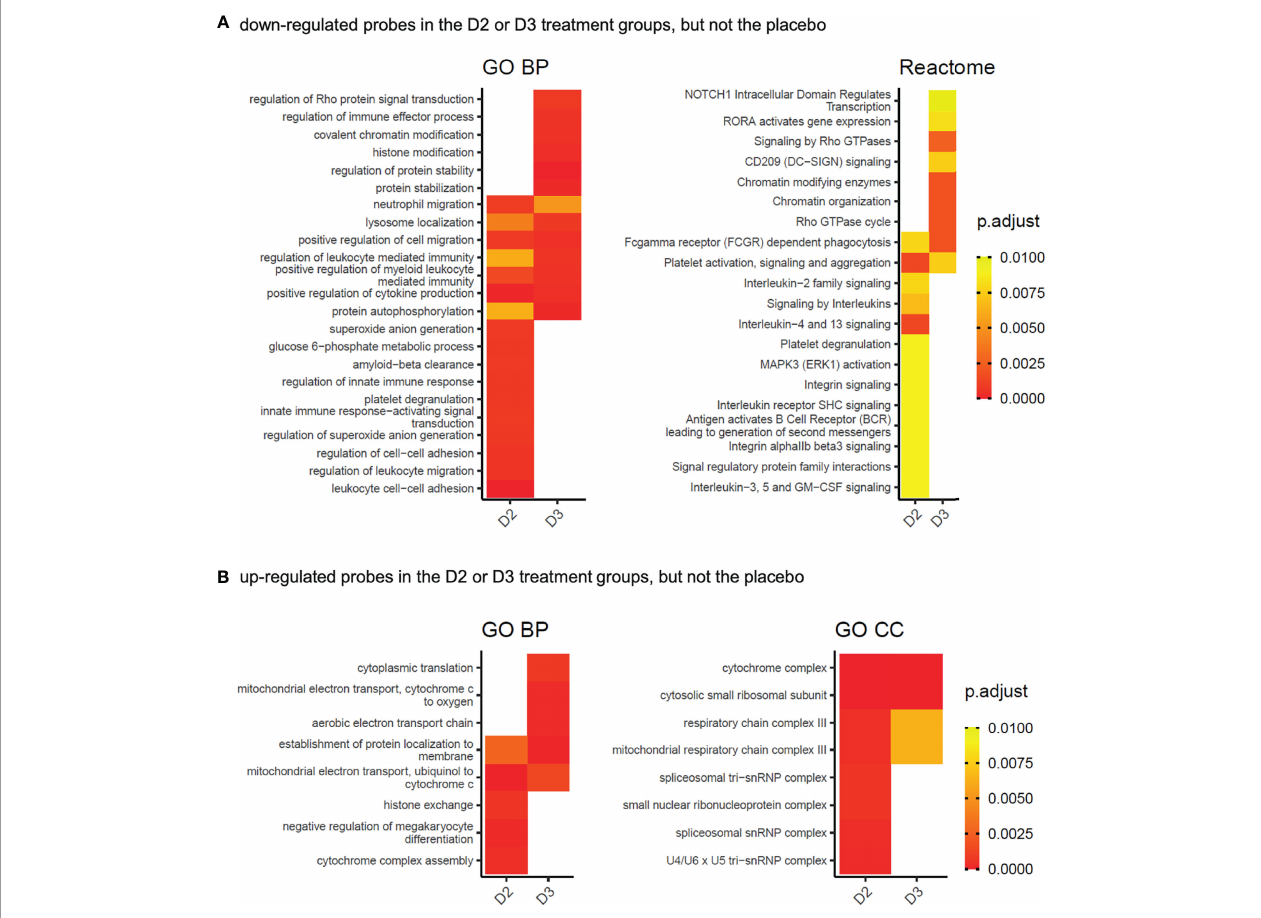
FIGURE 4 | Gene Ontology biological process (GO BP), cellular compartment (GO CC), or Reactome pathway functional categories signi fi cantly enriched in the gene products represented by the probes (A) signi fi cantly down-regulated (adj.P.Val ≤ 0.05) in the D2 or D3 treatment groups of the WE cohort, but not in the placebo group, and (B) signi fi cantly up-regulated (adj.P.Val ≤ 0.05) in the D2 or D3 treatment groups of the WE cohort, but not in the placebo group. Gene products represented by the signi fi cantly down-regulated probes in the comparisons WE D2 V3 v V1, WE D3 V3 v V1 and WE P V3 v V1 from Figure 2A , and possessing ENTREZ identi fi ers, were subjected separately to functional enrichment analysis using compareCluster (38). The details for each group are given in Supplementary Data File 4 . Signi fi cantly enriched categories (p.adjust ≤ 0.01) from all groups were processed as described in the Methods section to visualise categories identi fi ed from the D 2 or D 3 treatment groups but not by the placebo. Heatmap tiles that are blank correspond to categories that did not meet the signi fi cance criteria applied during the processing. The complete networks for each differentially expressed group of genes are shown in Supplementary Data File 5